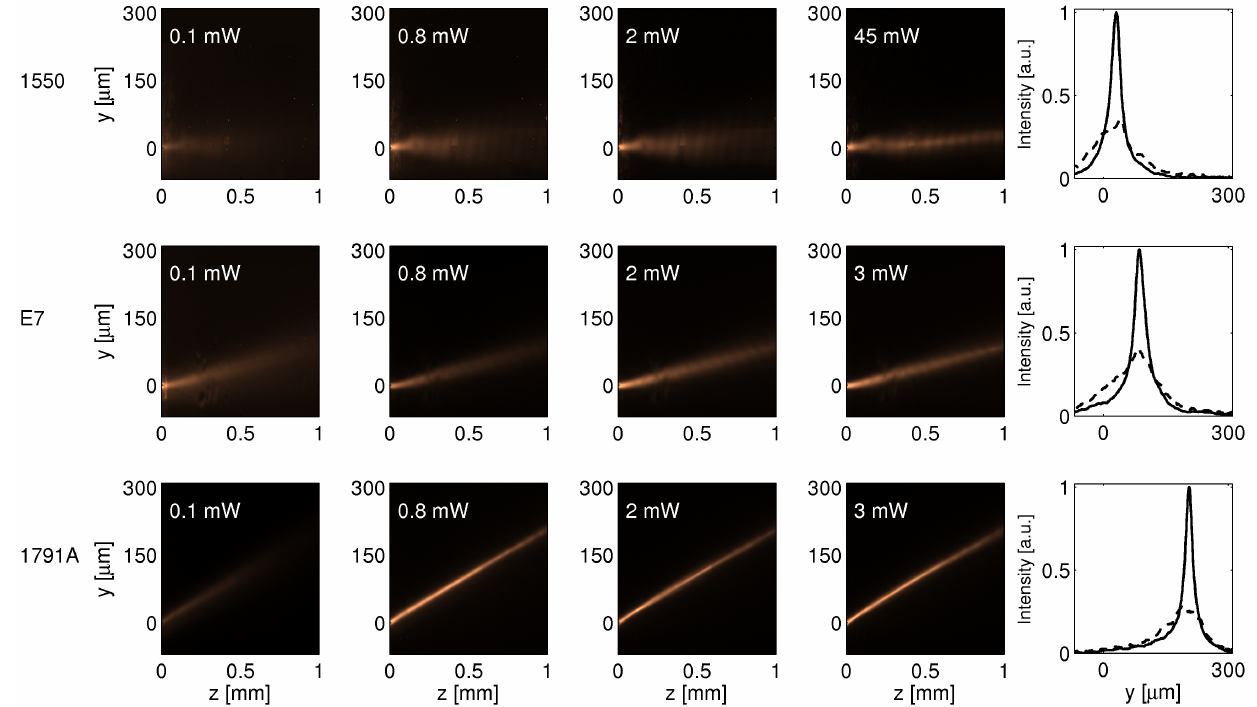
Figure 4. Beam propagation in three (undoped) NLC mixtures. As birefringence goes up, walk-off increases, whereas self-confinement is appreciable at lower powers. The rightmost graphs plot linear (dashed line) and nonlinear (solid line, corresponding to the highest excitation) output beam profiles across y